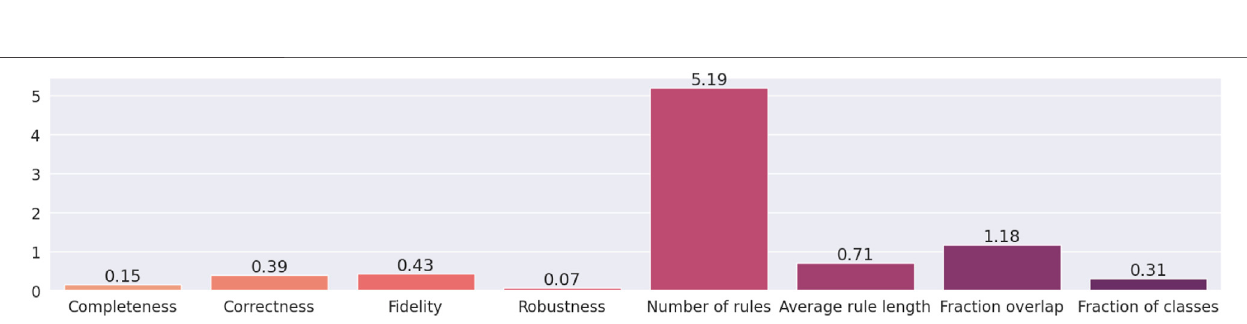
FIGURE 9 | Information entropy of the eight metrics for